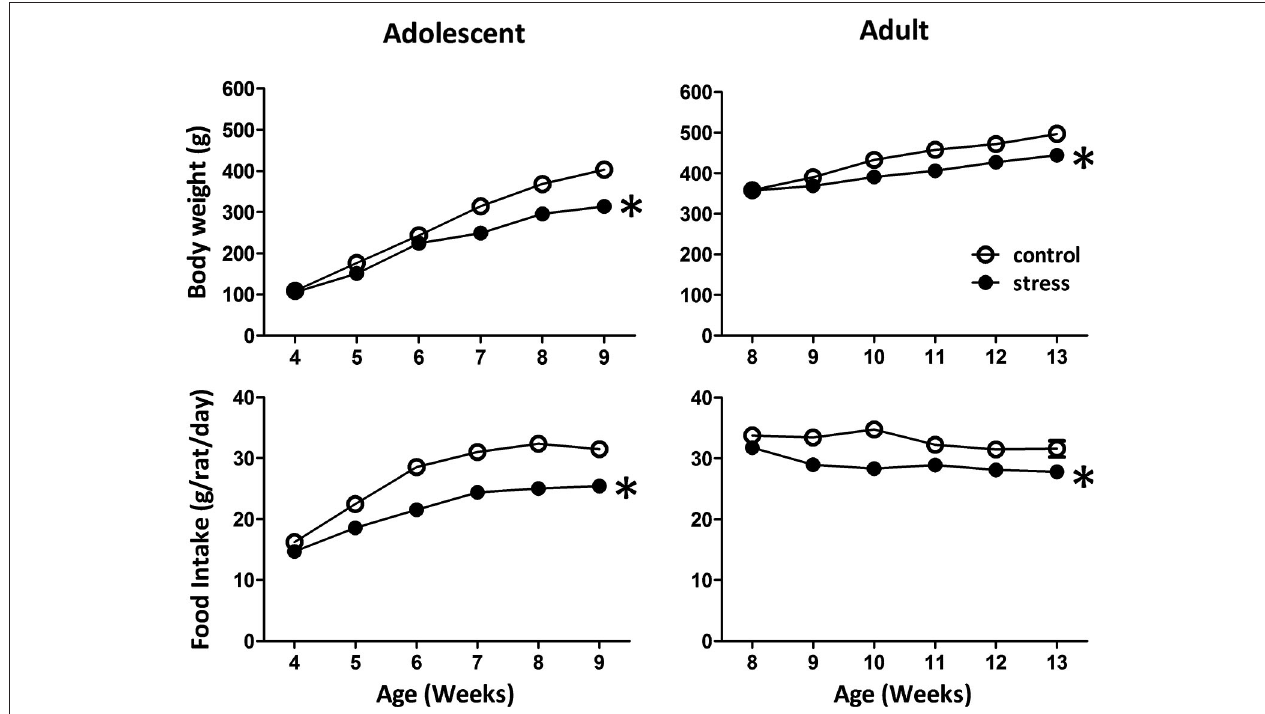
FIGURE 1 | Effects of stress on body weight and food intake in adolescent and adult rats. The body weight and food intake were monitored to evaluate the stress responses in adolescent and adult rats. * significantly different between control and stress groups, repeated measured ANOVAs.